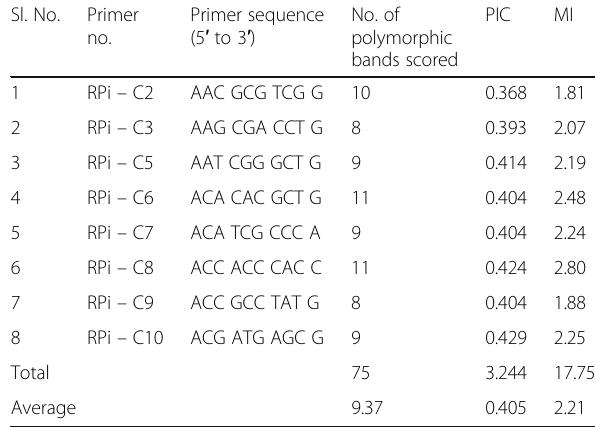
Table 2 Details of primers used in RAPD analysis of S.